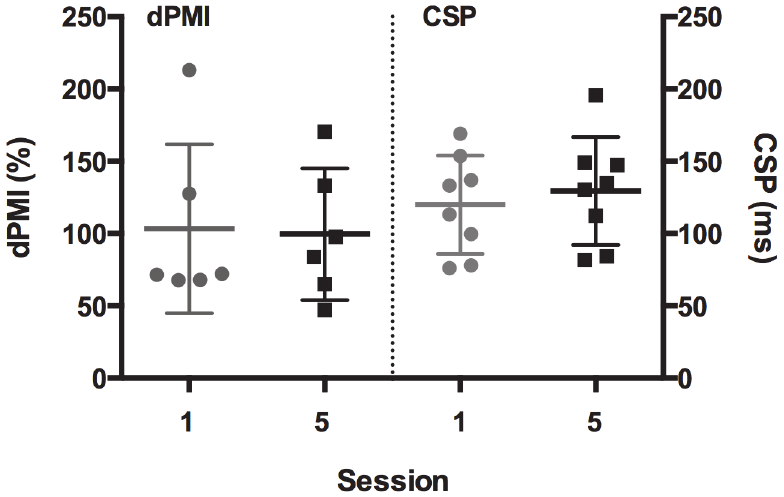
Fig 5. dPMI expressed as a percentage (MEP amplitude conditioned+test/MEP amplitude test alone * 100) from pre-Session 1 and pre-Session 5. CSP durations shown in msec from pre-Session 1 and pre- Session